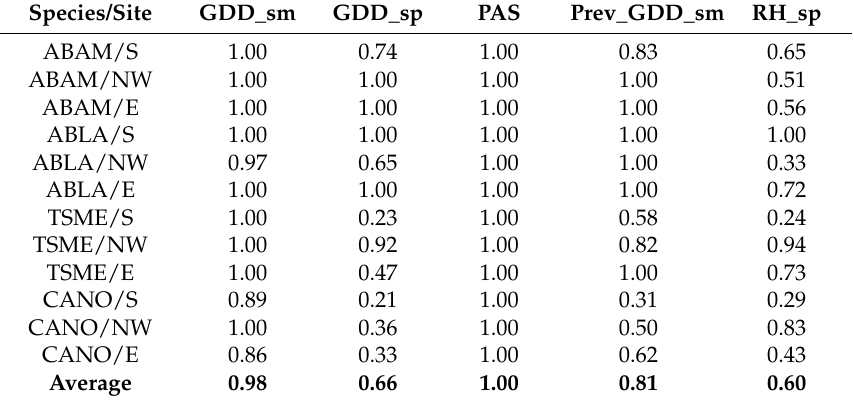
Table 1. Importance factors (proportion of top models including the variable) for RWI/climate variable relationships for all species at each site. Importance factor values range from 0 to 1, 1 being the most important. (sm = summer, sp = spring, prev = previous, GDD = growing degree days, PAS = precipitation as snow, RH = relative humidity). Note: species codes in column 1 are the first two letters of the genus and the first two letters of the species